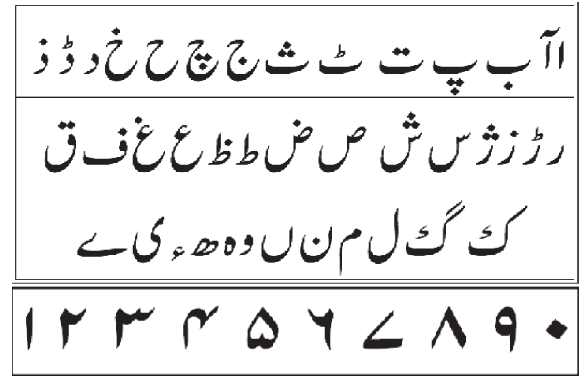
Figure 4: Urdu characters and